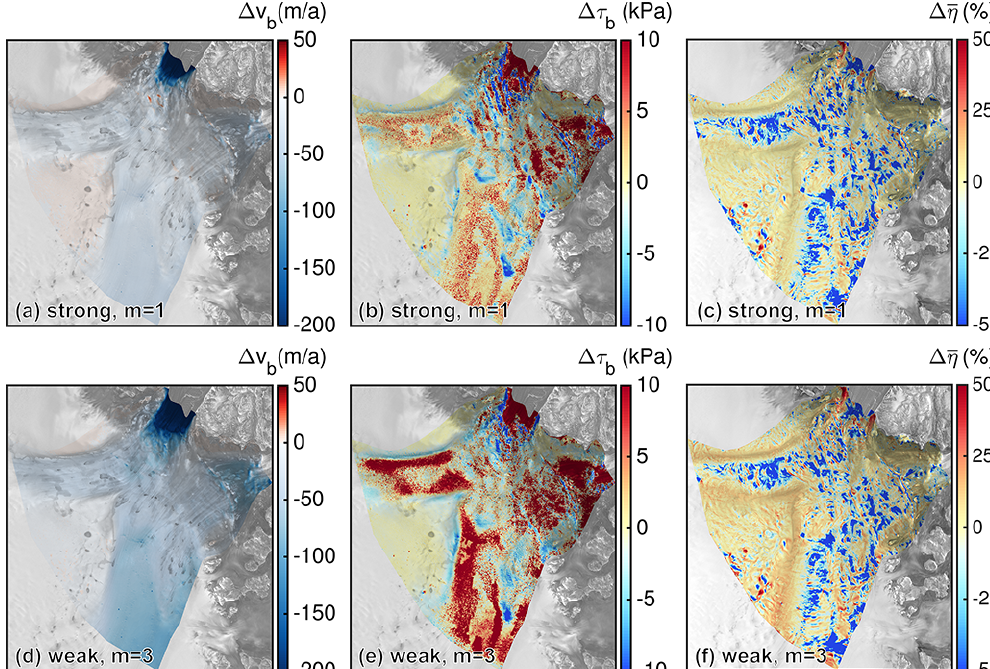
Figure 12. Comparison of characteristic quantities for a resolution of l = 150m and E = 1 at the outlet domain. The upper row (a–c) shows absolute difference of basal velocities v b (a) , basal drag τ b (b) and relative difference of depth-averaged viscosity ¯ η (c) for m = 1 and P1P1GLS strong. The domain-averaged mean viscosities for FS are 3 . 00 × 10 14 and for BP-like 3 . 40 × 10 14 Pas. The lower row (d–f) shows the equivalent fields but for m = 3 and P1P1GLS weak. The domain-averaged mean viscosity for FS is 3 . 11 × 10 14 and for BP-like